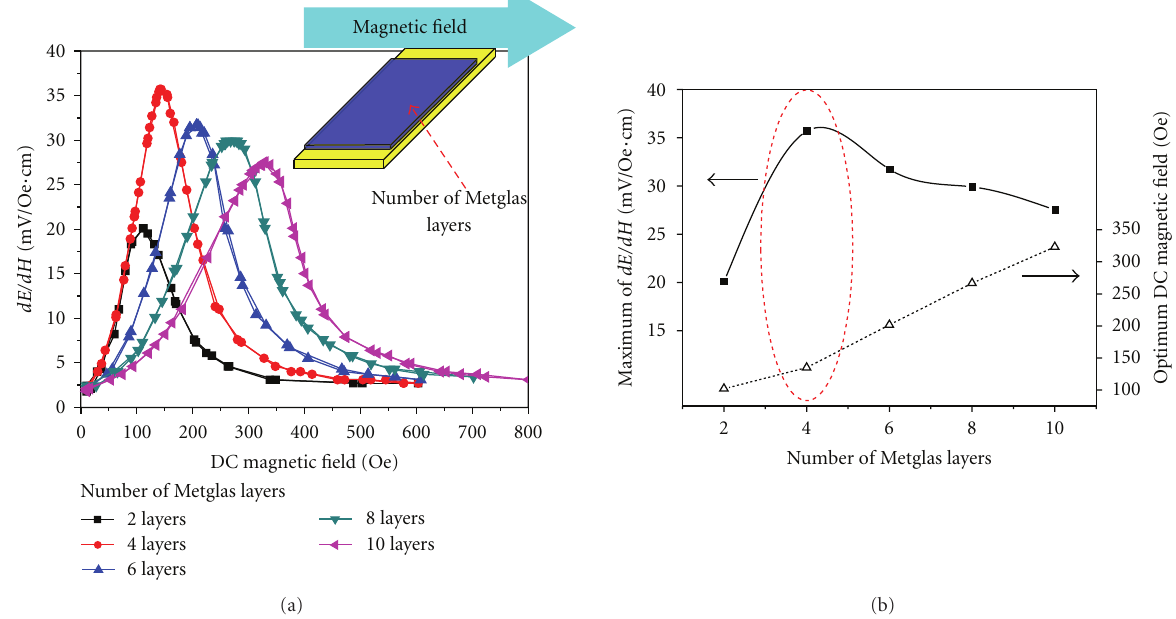
Figure 3: (a) ME coe ffi cient as a function of the number of Metglas layers and DC magnetic field. (b) Maximum ME coe ffi cient and optimum DC magnetic field as a function of the number of Metglas layers on PZNT. All measurements were conducted under the constant condition of H ac = 1Oe at f = 1kHz